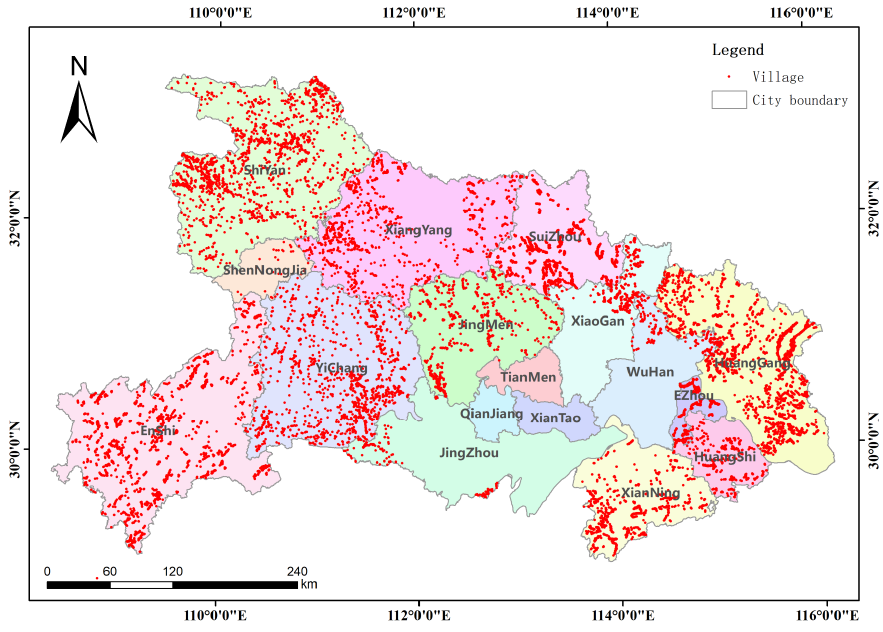
Figure 2. The Villages Affected by Flash Floods in Hubei Province.